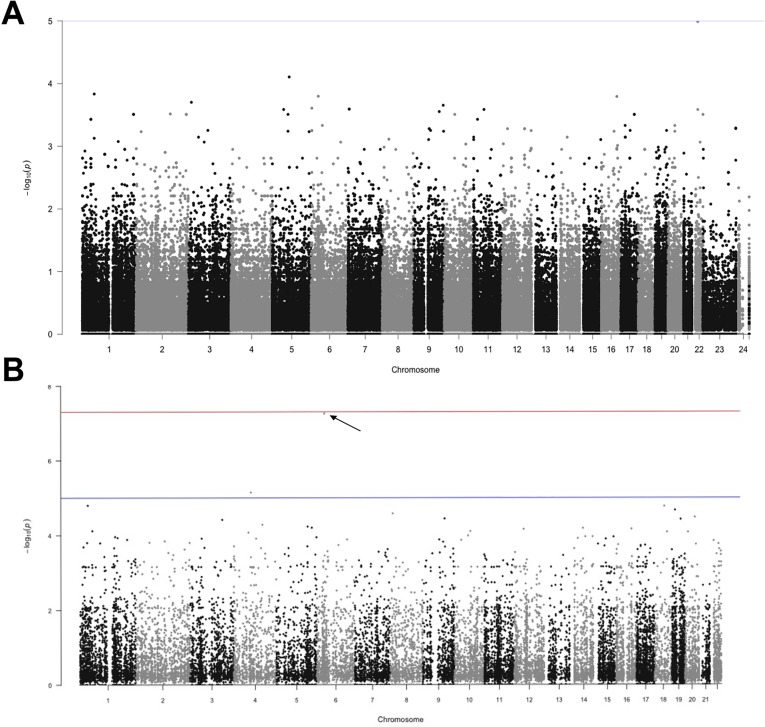
Manhattan plot of p-values.(A) Fisher exact tests performed on genotype counts for common variants identified by whole exome sequencing in the mild versus severe groups. (B) Association tests based on aggregated sets of both common and rare contiguous SNPs across the exonic regions of the genome. P-value associated with FKBP5 is indicated with arrow.